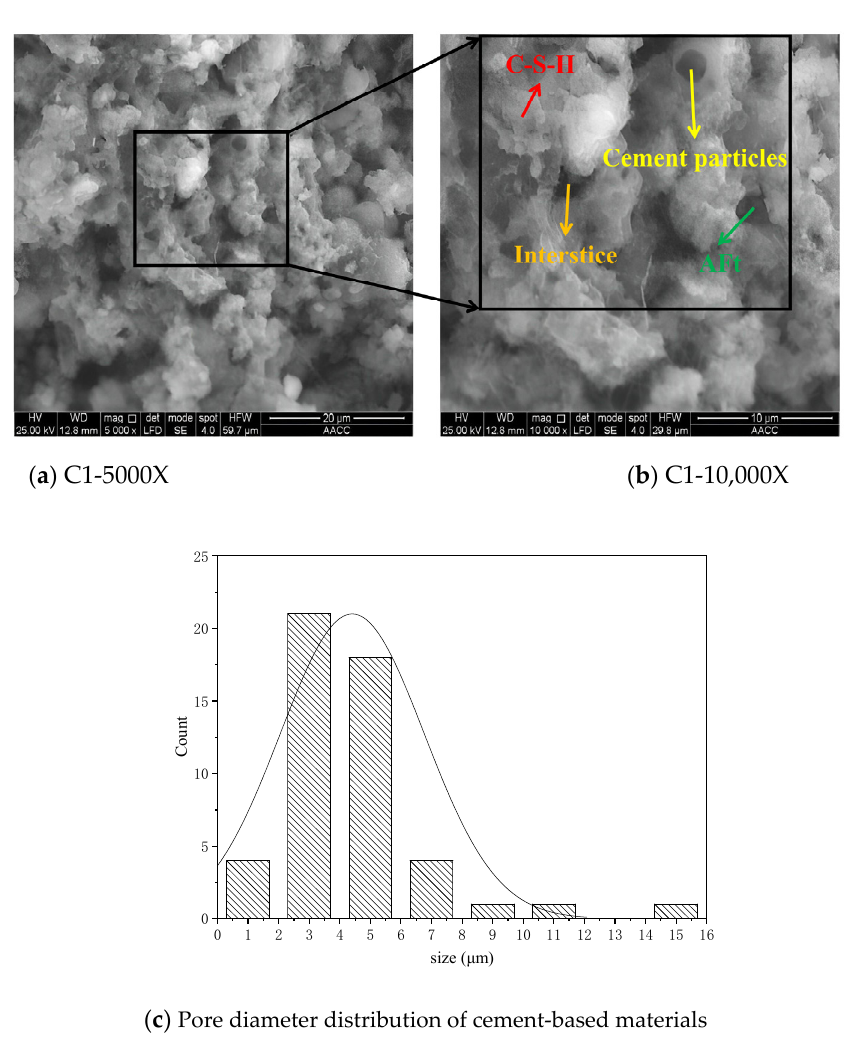
Figure 7. The microstructure of cement-based materials and pore distribution.